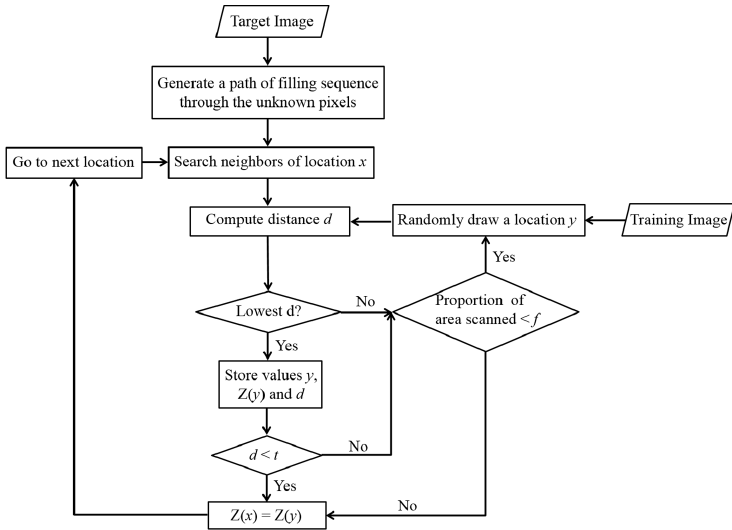
Figure 2. Flowchart of the Direct Sampling method using a single training image. In the flowchart, x and y are the locations of the pixels in target image and training image respectively. Z ( x ) and Z ( y ) are the values at corresponding locations; d is the distance between two data events N x and N y , which can be denoted as d { N x , N y }. f is the maximum search proportion of scanned training image and t is the user-defined threshold.